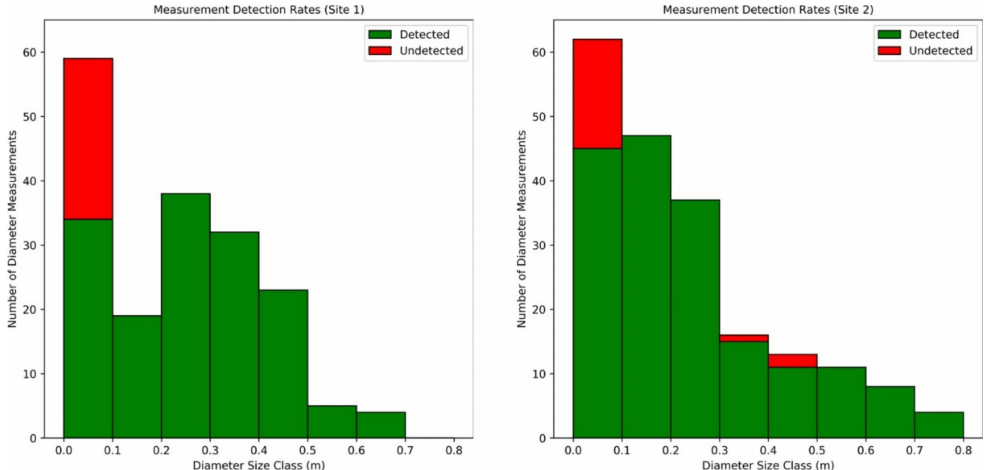
Figure 14. Histograms showing detection rates for Site 1 ( Left ) and Site 2 ( Right ). The undetected diameter measurements are stacked above the detected diameter measurements to give the total number of measurements in each size class. A stem was considered detected if validated CCI was